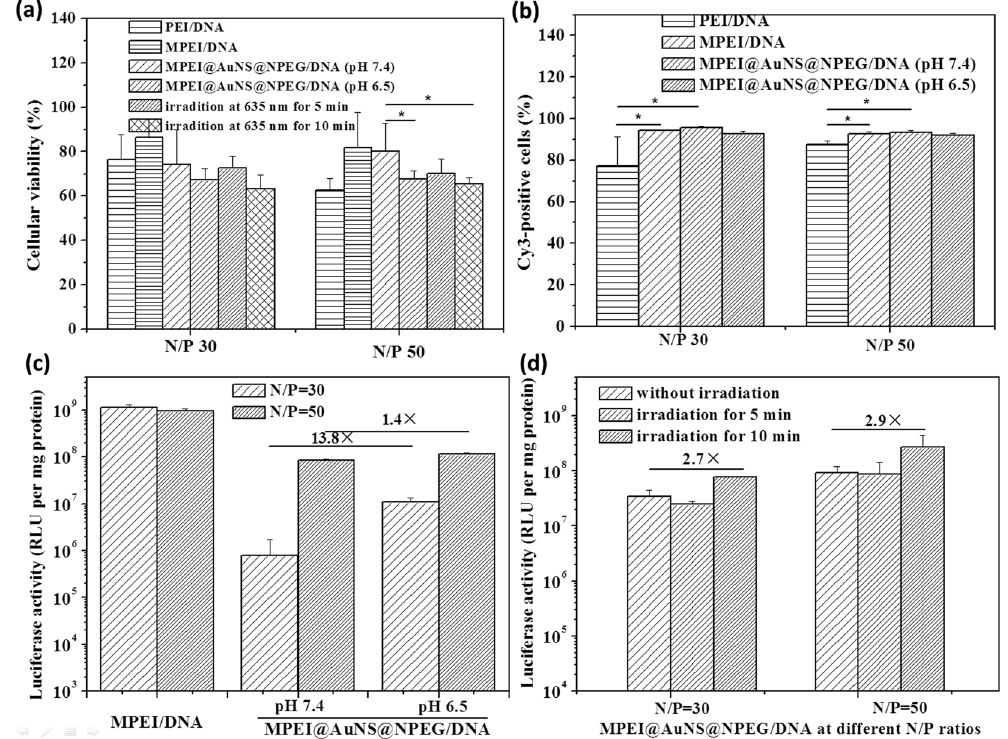
Figure 6. ( a ) Cellular cytotoxicity and ( b ) cellular uptake assays of different DNA polyplexes; ( c ) In vitro gene transfection of polyplexes as pH lowed; ( d ) In vitro gene transfection of polyplexes under light irradiation. (Error bar stood for S.D.; * Referred that p <